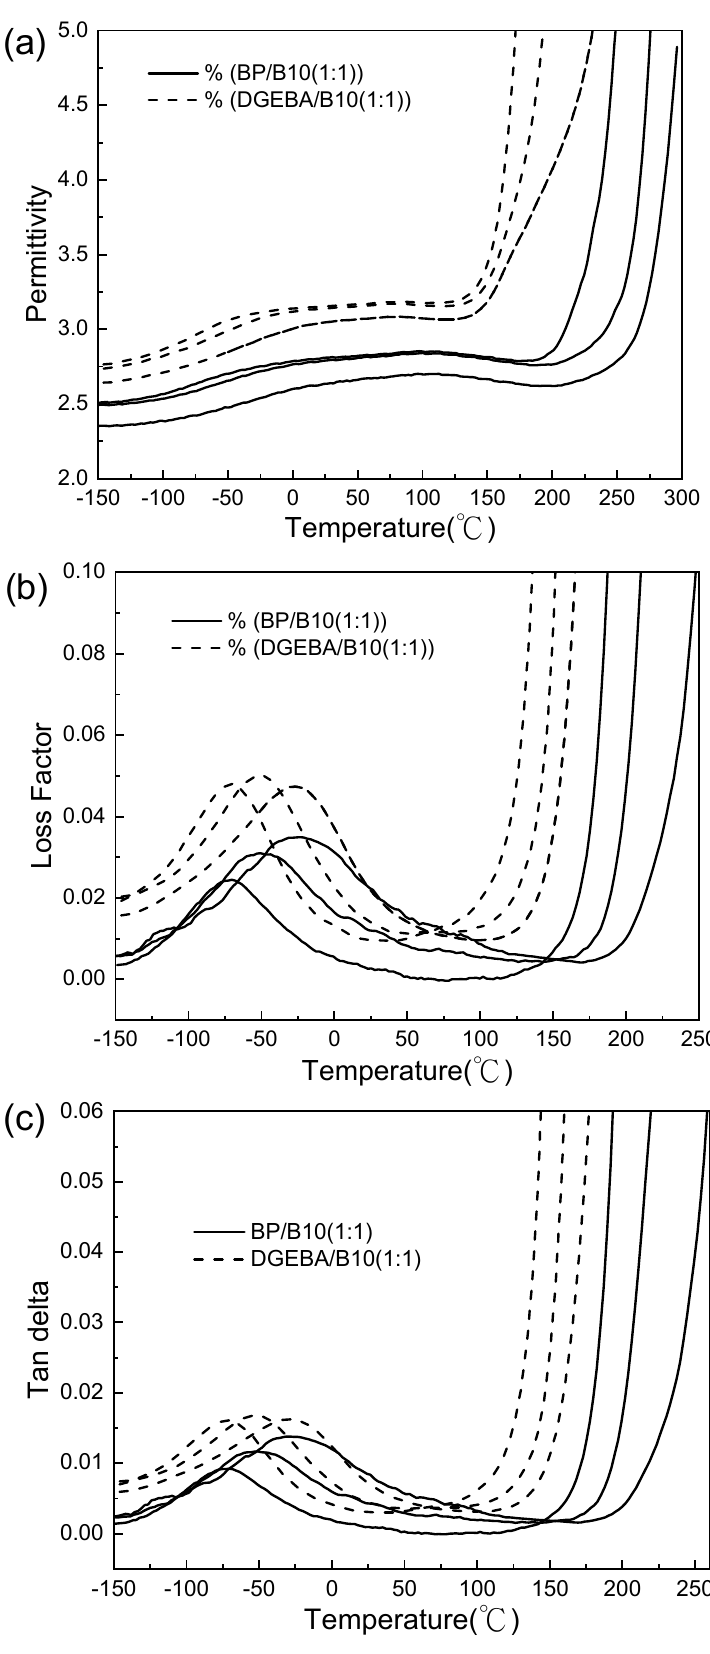
Figure 8. ( a ) Permittivity, ( b ) loss factor and ( c ) tan delta of cyanate ester (B10)-cured epoxy at 100, 1000 and 10,000 Hz (curves from left to